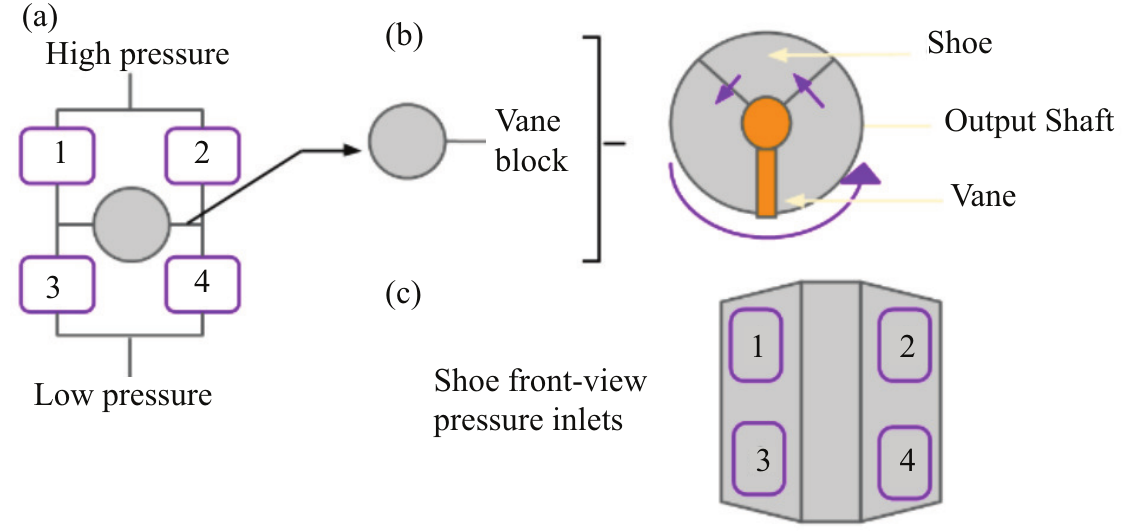
Figure 3. A schematic representation of an ERF actuator controlled by four ERF valves is